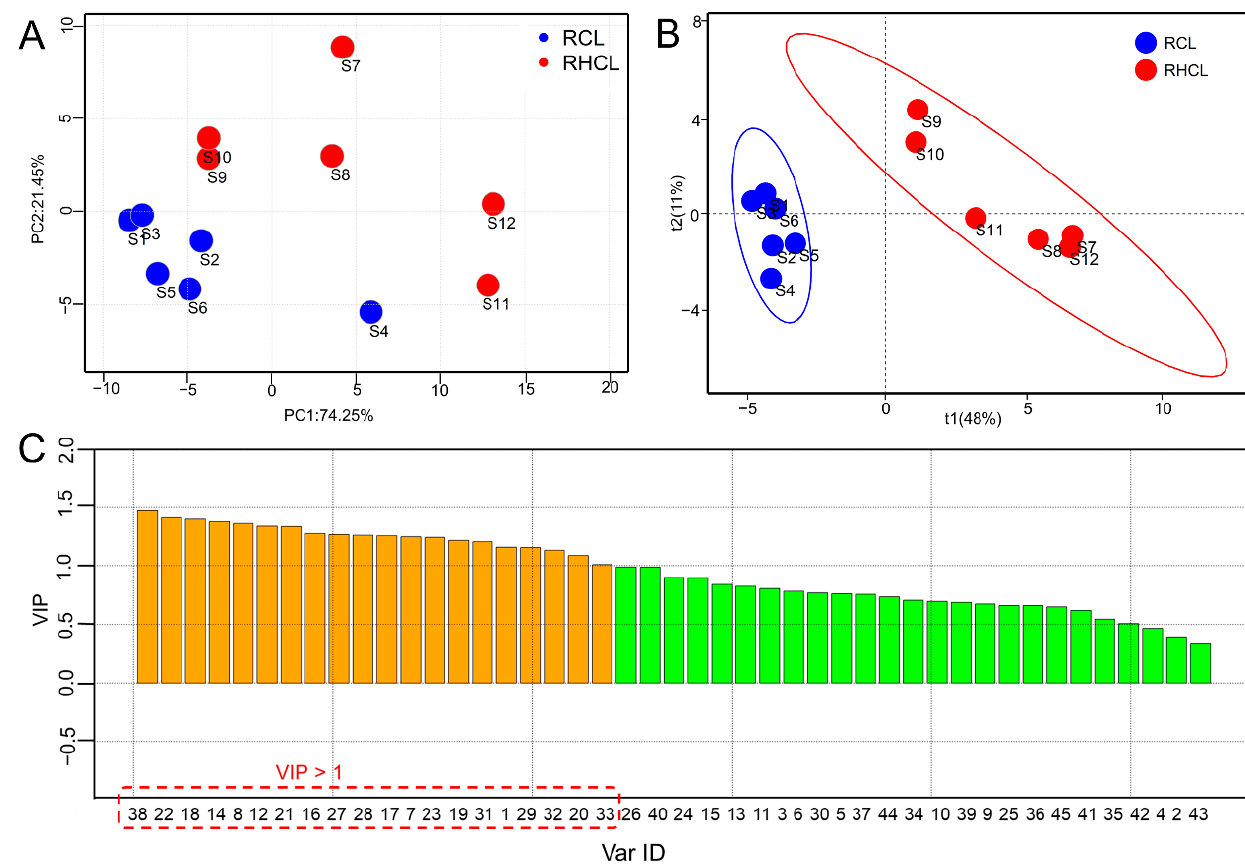
Figure 4. Two-dimensional PCA ( A ) and PLS-DA ( B ) score plot of RCL and RHCL volatile oil samples. The VIP plot ( C ) obtained from PLS-DA.